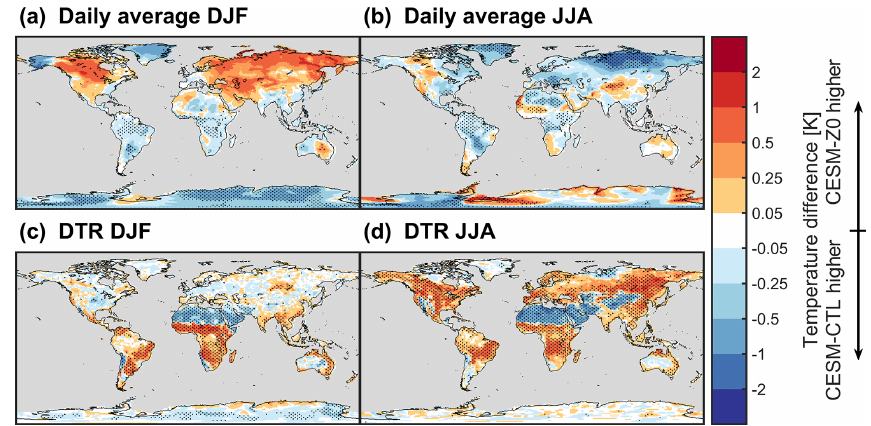
Figure 12. (a–b) Seasonal average difference in air temperature at the bottom of the atmospheric column (TBOT) between CESM-Z0 and CESM-CTL using data from the last 30 years of the spinup period and data from the analysis period (15 years). (c–d) Difference in TBOT DTR. The stippling shows areas with a difference that is statistically significant different from 0 in a two-sided t test at the 95% confidence level with a controlled false discovery rate. (a, c) Boreal winter (DJF) and (b, d) boreal summer (JJA). Note the non-linear color scale.